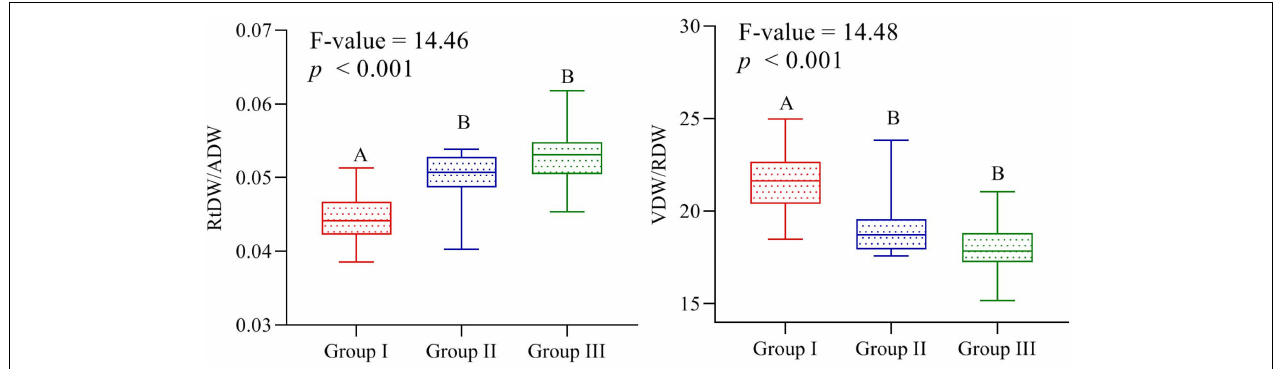
FIGURE 3 | Comparison of root dry weight/aboveground dry weight and vegetative dry weight/reproductive dry weight ratios among the three groups separated on an elevation basis. Different letters indicate significant difference at p < 0.05.